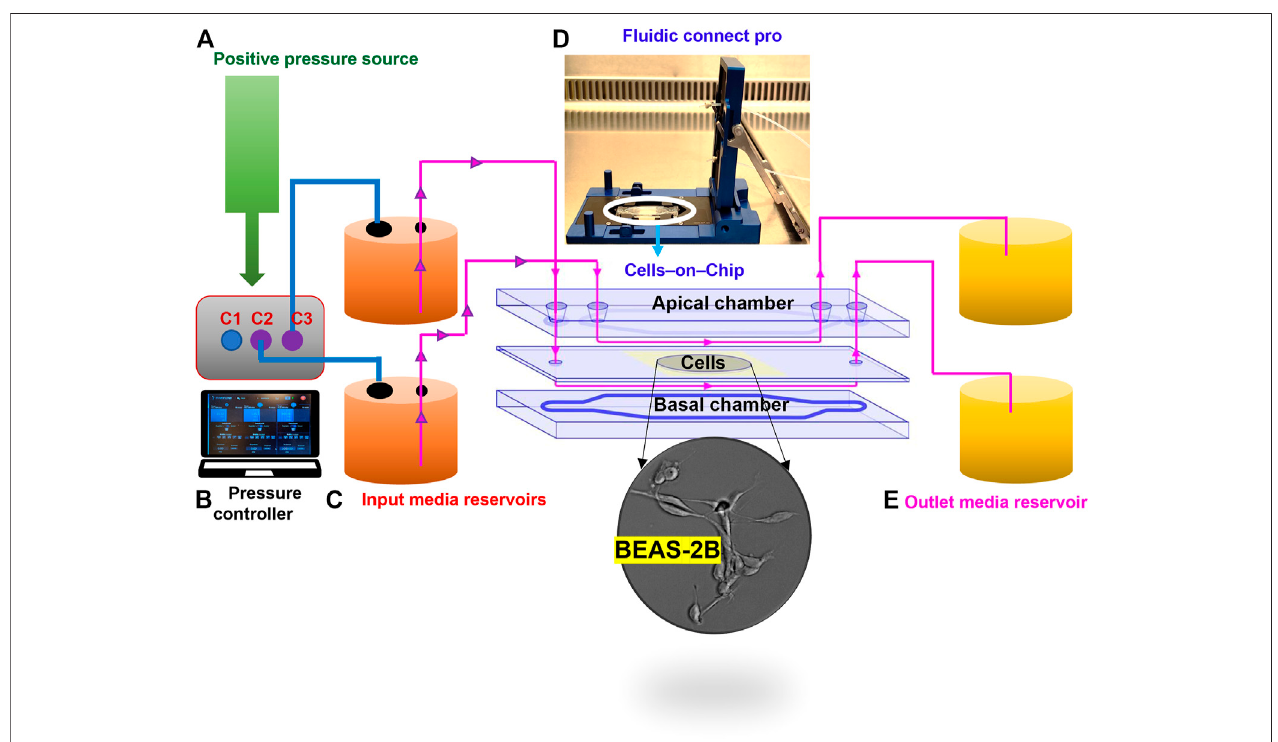
FIGURE 1 | Con fi guration of the micro fl uidic cell culture-on-a-chip (COC) platform. The device consists of fi ve different parts: clean air supplied as a positive pressure source (A) , for the digitally operated pressure controller with three de fi ned channels to sustain maximum pressures; 10 bar in C1 and 1 bar in C2 and C3 (B) ; then, the desired amount of pressure supplied to the inlet reservoirs through tubing (C) , which enables the fl ow of medium through the fl uidics connect pro device that holds the COC chambers to allow unidirectional fl ow of medium through the apical and basal sides of the human lung cells in the central cavity (D) ; fi nally, fl ow through is collected in outlet reservoir (E)